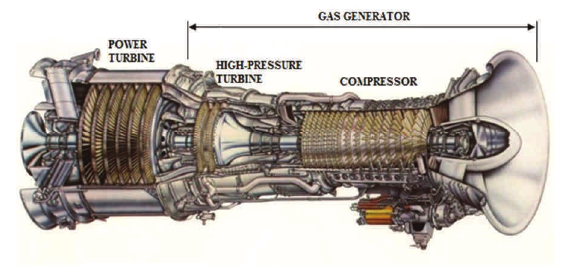
Fig. 1. Cross-section of LM-2500 naval gas turbine [18]